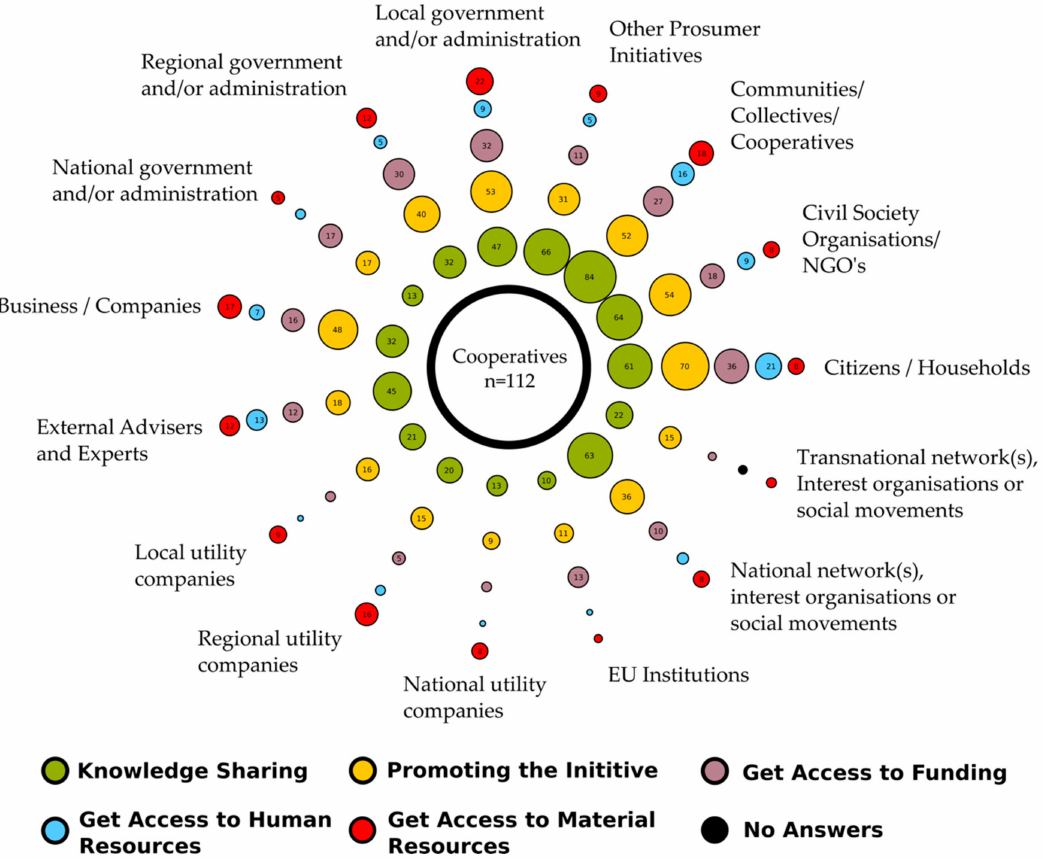
Figure 11. Key networking relationships cultivated by initiatives (please consult Document S2 for plots of top legal